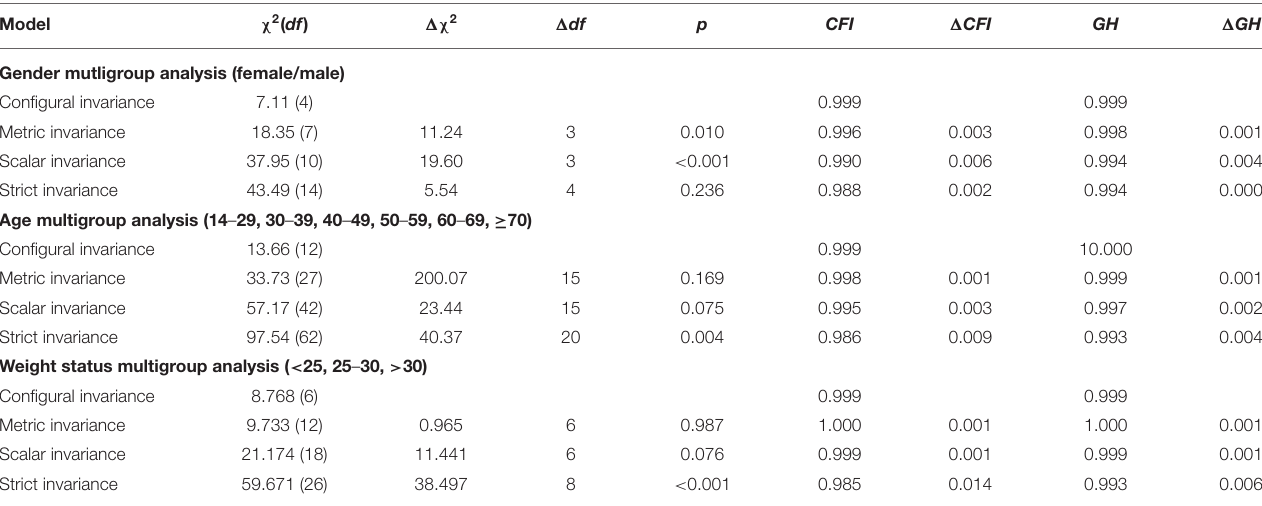
TABLE 4 | Analysis of measurement invariance (Sample 2).